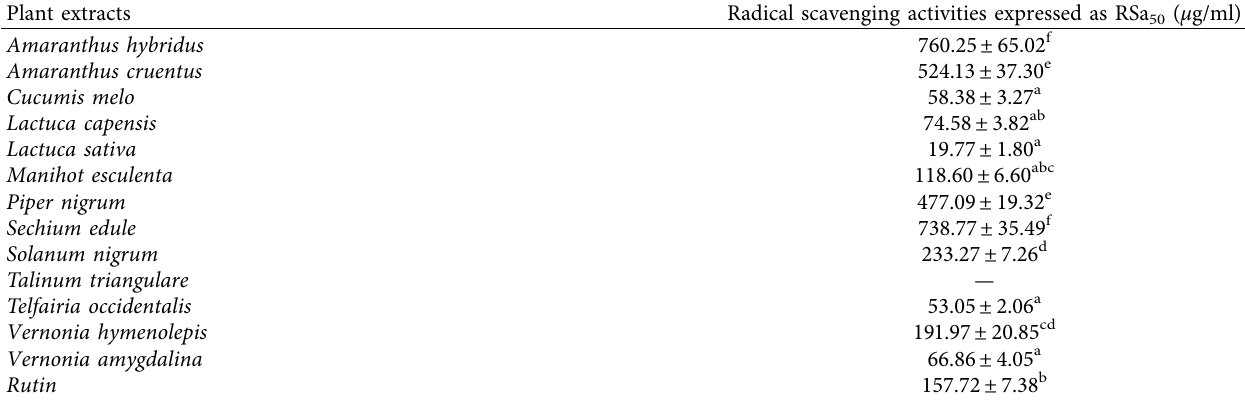
Table 6: NO radical scavenging activities of the methanol extracts of thirteen antibacterial edible plants. Plant extracts Radical scavenging activities expressed as RSa 50 ( μ g/ml)